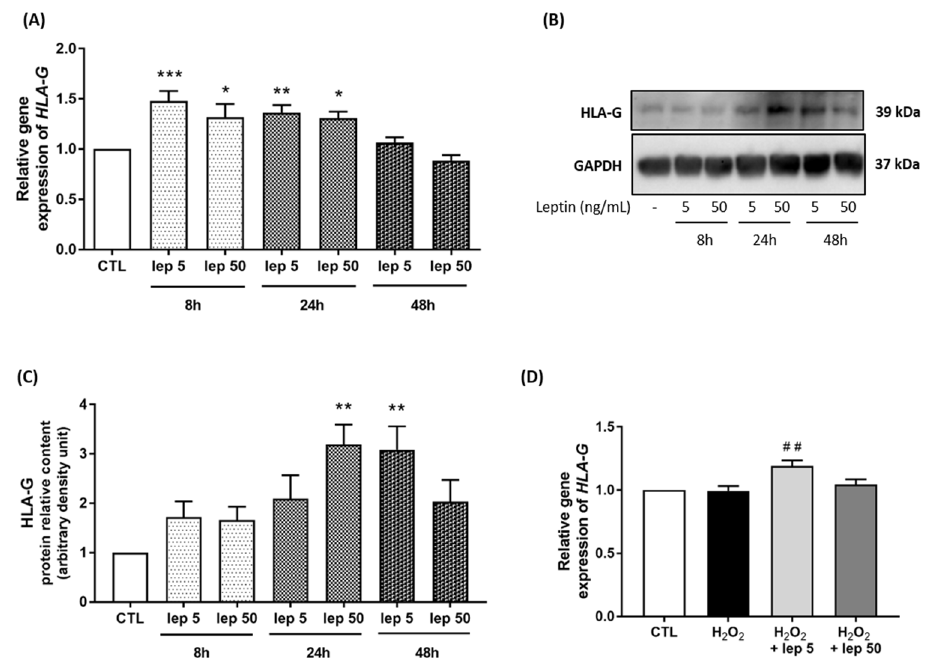
Figure 6. HLA-G expression induced by leptin in myometrial cells. Myocytes were stimulated with leptin at 5 and 50 ng/mL for 8 h, 24 h and 48 h. ( A ) Quantification of HLA-G mRNA levels analysed by qRT-PCR in myometrial cells. Results are expressed as fold induction versus CTL (mean ± SEM), of four replicate reactions. * p < 0.05, ** p < 0.01 and *** p < 0.001 versus CTL. ( B , C ) Representative blots of HLA-G and GAPDH proteins and densitometric analysis of HLA-G expression as fold induction versus CTL (mean ± SEM) and expressed in ADU, n = 4, ** p < 0.01 versus CTL. ( D ) Quantification of HLA-G mRNA expression in myometrial cells following H 2 O 2 +/− leptin stimulation. ## p < 0.01 versus H 2 O 2 .